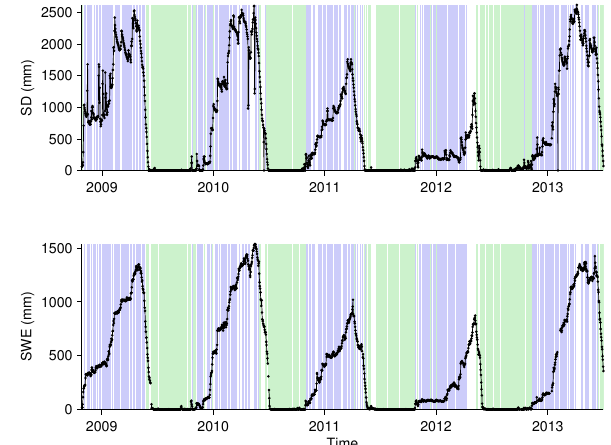
Figure 3. Time series of in situ data and MODIS data at Ordiceto station. The black dots are the daily snow depth (SD) and snow water equivalent (SWE) measurements. The color bars in the back- ground indicate the snow presence (blue), absence (green) and no data (white) from